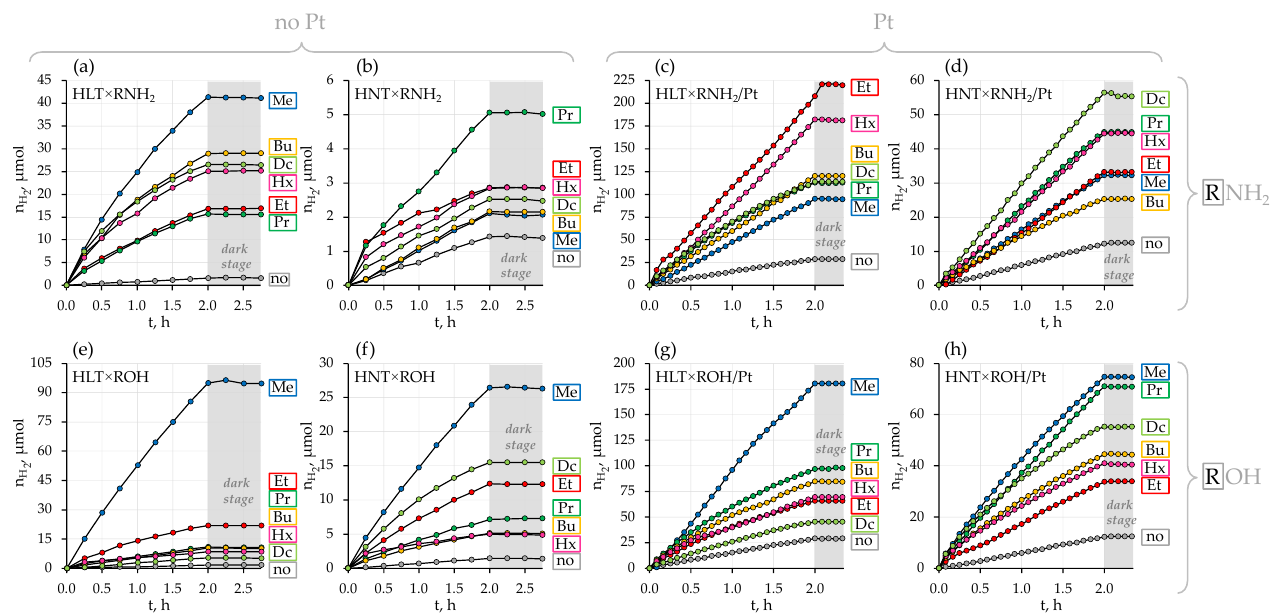
Figure 3. Kinetic curves of photocatalytic hydrogen evolution over the initial protonated titanates, their n -alkylamine ( a – d ) and n -alkoxy ( e – h ) derivatives in a bare state and with a Pt cocatalyst from 1 mol. % aqueous methanol under near-ultraviolet irradiation. Grey background corresponds to the dark stages (irradiation source is turned off).